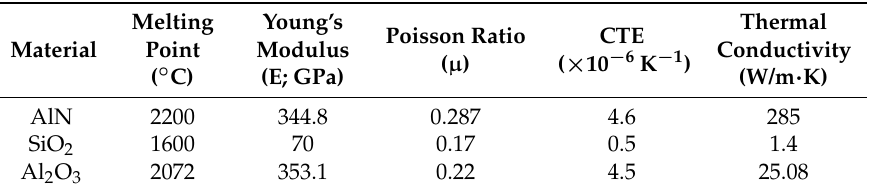
Table 2. Properties of insulators used in MIM-PMAs. Adapted with permission from Reference [43]. © 2017 American Chemical